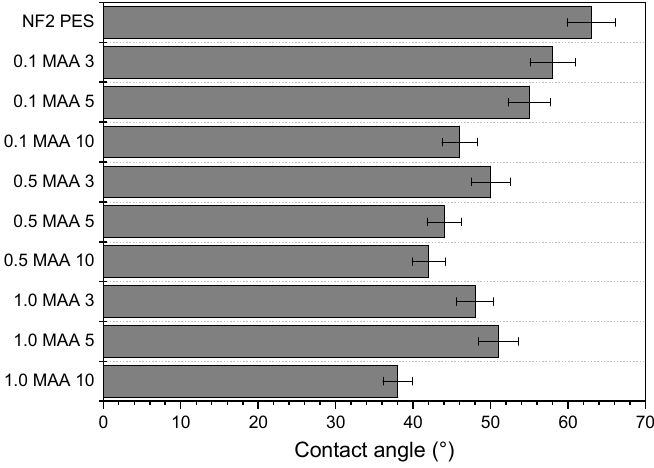
Figure 3. Water contact angle of the unmodified and UV-grafted membranes.